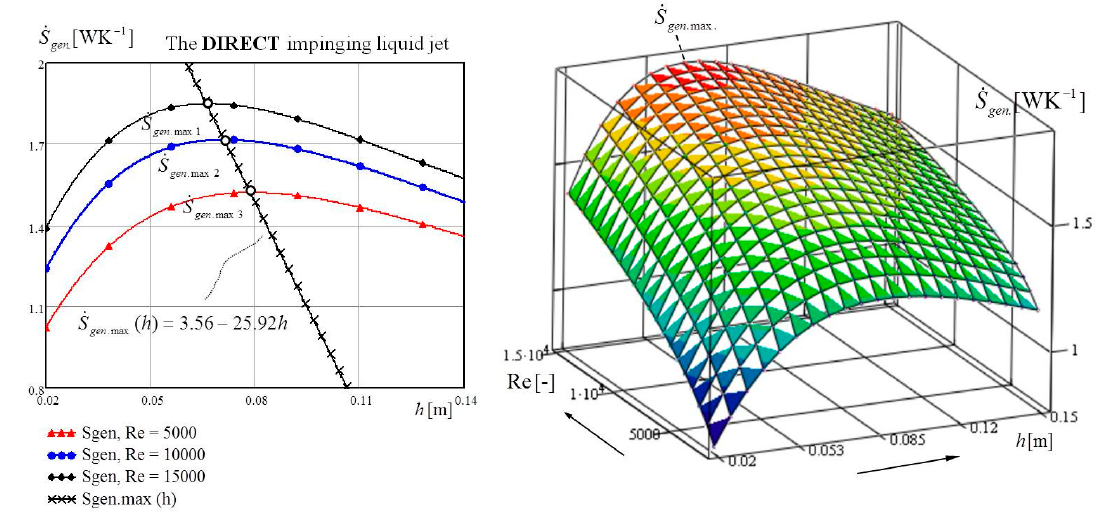
Figure 18. The maximum entropy generation for direct impinging liquid